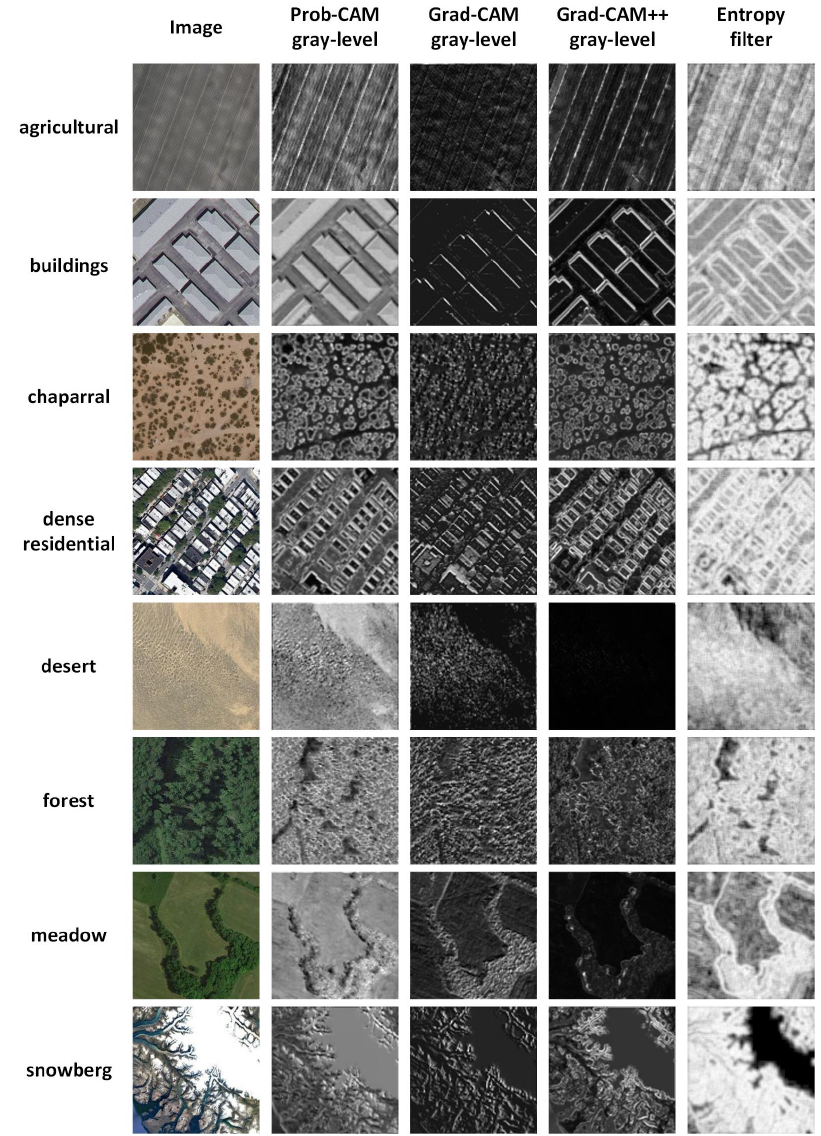
Figure 9. The gray level maps of Prob-CAM and Grad-CAM on the shallow layer, and the texture image obtained by the entropy